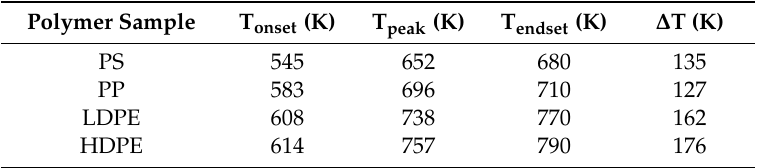
Figure 1. Thermogravimetric (TG) curves of pure polymer samples.